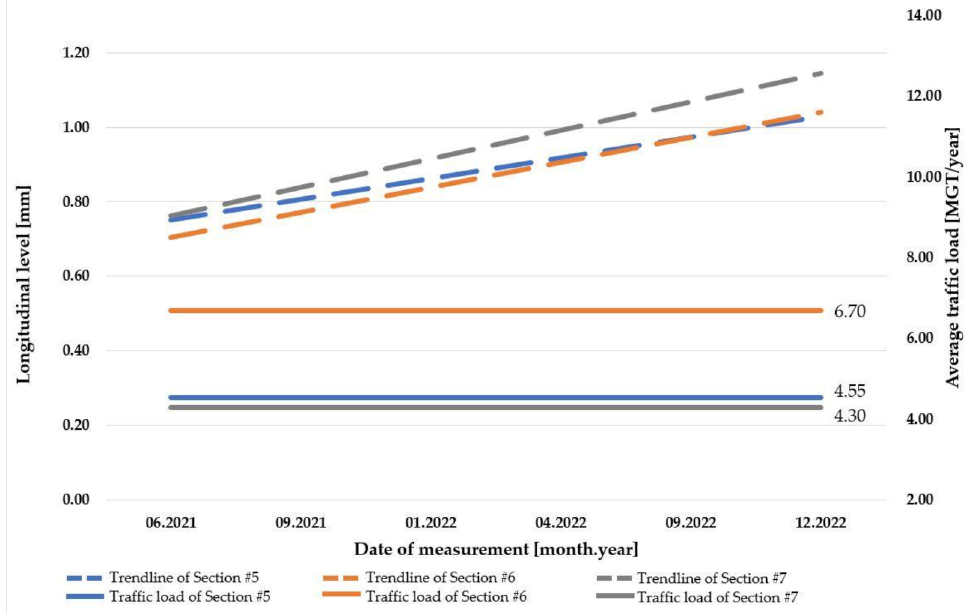
Figure 29. The relationship between longitudinal level and traffic load in concrete slab track